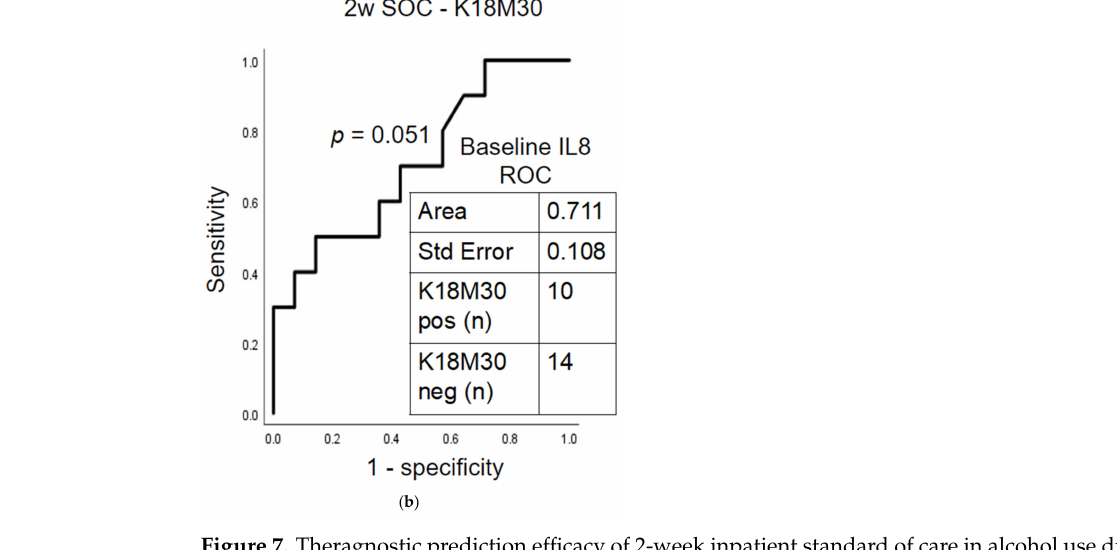
Figure 7. Theragnostic prediction efficacy of 2-week inpatient standard of care in alcohol use disorder patients for improvement in K18M30 in Gr.2. ( a ) True positivity of baseline IL-8 response in predicting K18M30 improvement to normal levels using AUROC Analyses with baseline; ( b ) after 2 weeks of standard of care. K18M30 as 250 IU/L as normal was used as the primary factor. Table 5. Liver injury measures, nutritional status, candidate blood panel measures, cytokines, gut dysfunction markers, and cell death markers of the alcohol use disorder patients at baseline comparing patients with improved K18M65 < 500 IU/L (Gr.2a) and patients with elevated K18M65 ≥ 500 IU/L (Gr.2b) within elevated FIB-4 patients (Gr